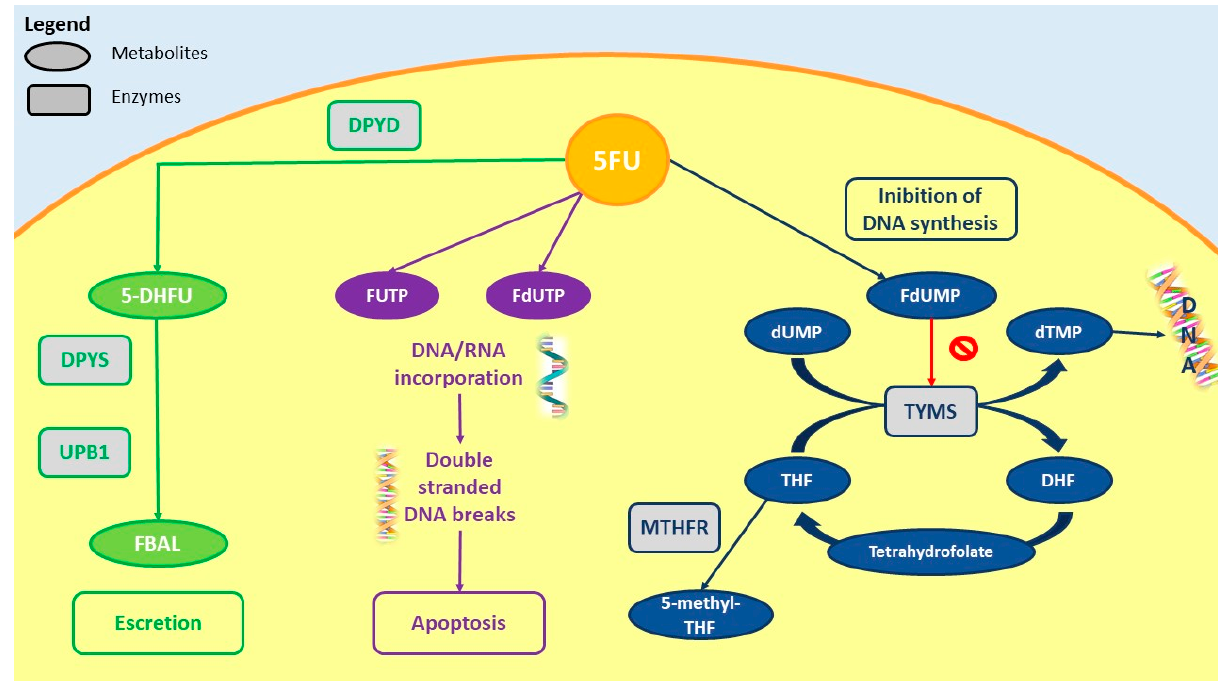
Figure 1. Metabolism and mechanism of action of 5-fluorouracil (5-FU) in colon cancer tissue. Liver dihydropyrimidine dehydrogenase (DPD) is responsible for about 90% of fluoropyrimidine metabolism by converting them into 5-DHFU. TYMS is an enzyme that plays a crucial role in the early steps of DNA biosynthesis by converting dUMP to dTMP using folate, donated by MTHFR and then incorporated in DNA and RNA as pyrimidine analogues, with consequent apoptosis in cancer cells. MTHFR usually converts THF in 5-methyl THF and uses it as a methyl donor. dUMP forms a ternary complex with THF and TYMS, with inhibition of the enzyme; thus, MTHFR deficiency could be responsible for 5,10- methylene-THF increase in cells, enhancing the inhibitory complex and fluoropyrimidine toxicity. TYMS polymorphisms could also be responsible for 5-FU-related toxicities. However, the roles of both MTHFR and TYMS polymorphisms still need to be translated to clinical practice, as the results of in vivo studies to date have been controversial; as such, there is no indication for testing them to drive clinical decisions. In contrast, testing DPD activity is strongly recommended before starting fluoropyrimidine therapy. In fact, DPD deficiency significantly increases the risks for the development of severe 5-FU-associated toxicity.